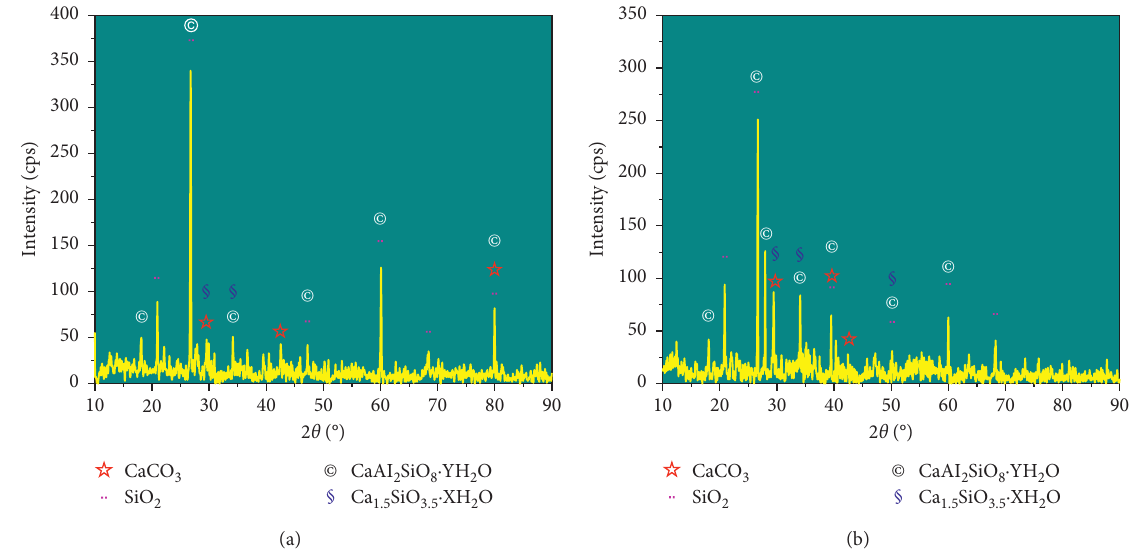
Figure 7: XRD diagram of common concrete and recycled concrete after degradation. (a) Ordinary concrete. (b) RCA concrete.